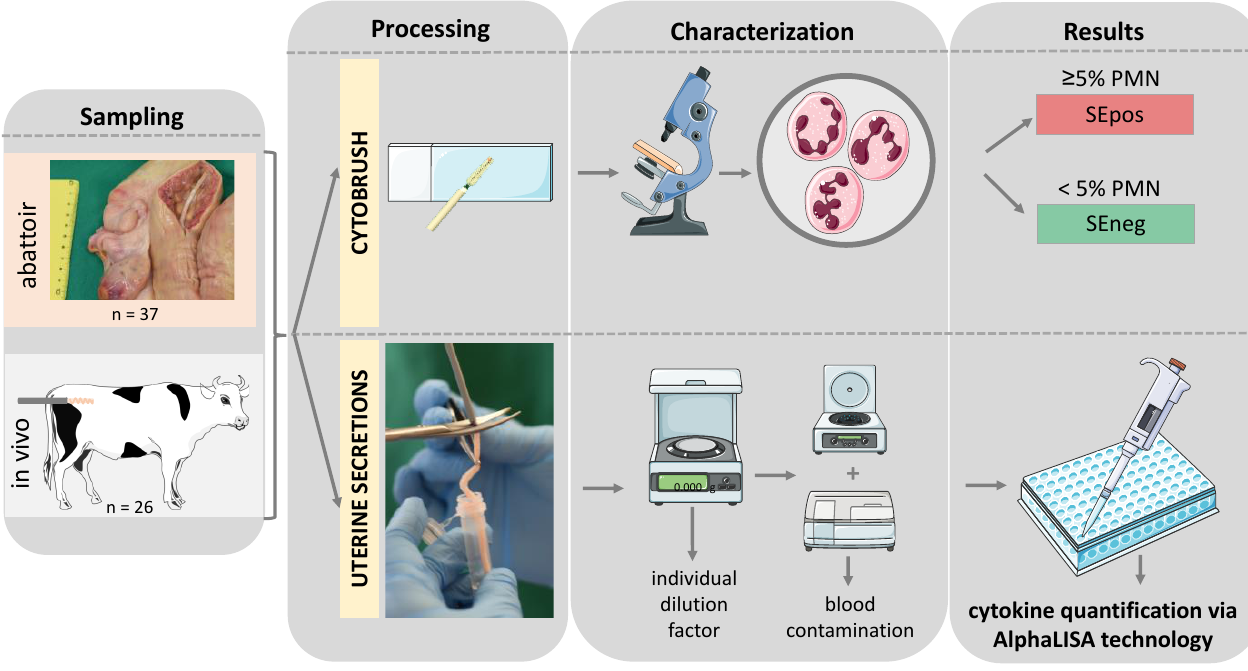
Figure 1. Schematic illustration of the experimental setup of this study. PMN—polymorphonuclear neutrophil granulocyte; SEpos/SEneg—positive/negative for subclinical endometritis (SE) detected via cytobrush; AlphaLISA—amplified luminescent proximity homogeneous assay-linked immunosorbent assay. Graphical elements retrieved from Servier medical art.